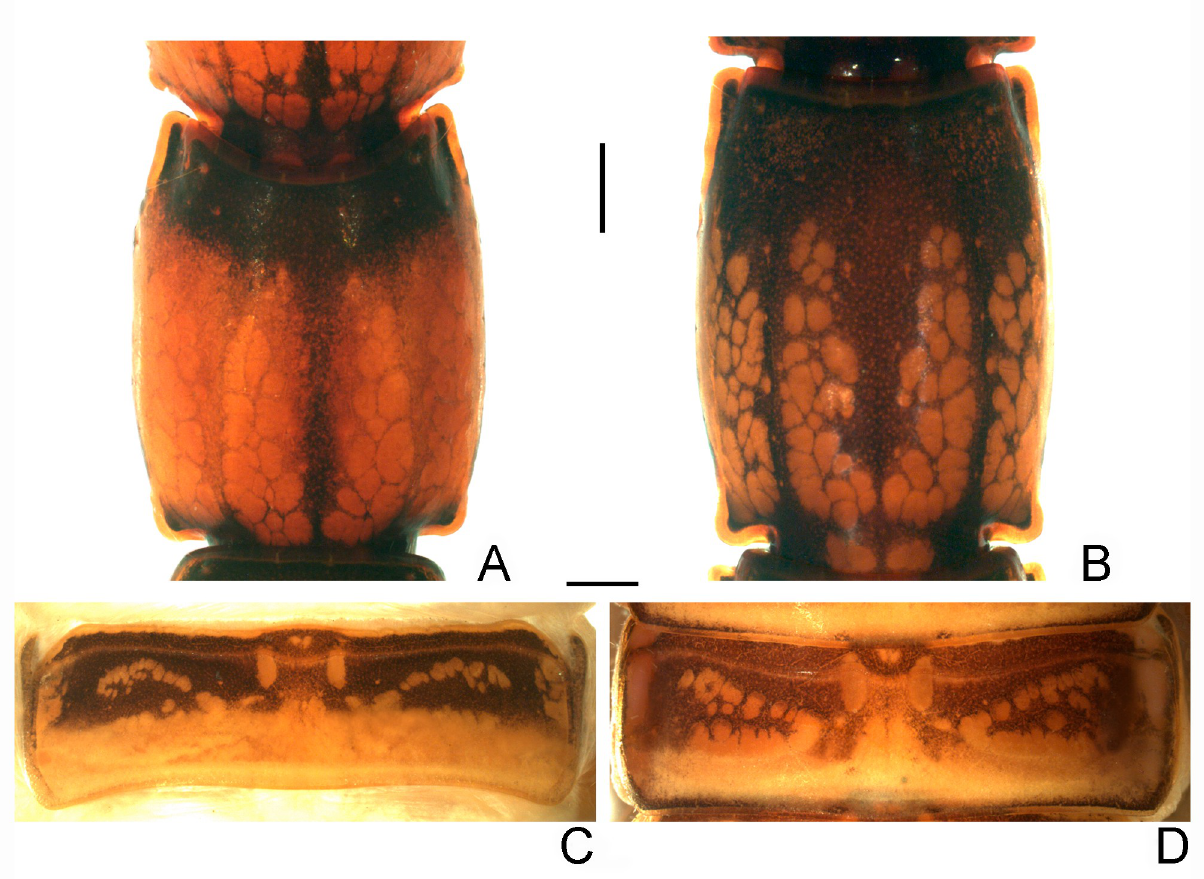
Fig 8. Diagnostic characters of pigment pattern of Bothriurus coriaceus and Bothriurus mistral n. sp. (A, C) Bothriurus coriaceus , (A) metasomal segment IV, ventral aspect. (C) terguite IV, dorsal aspect. (B, D) Bothriurus mistral n. sp. (B) metasomal segment IV, ventral aspect, (D) terguite IV, dorsal aspect. Scale bars: